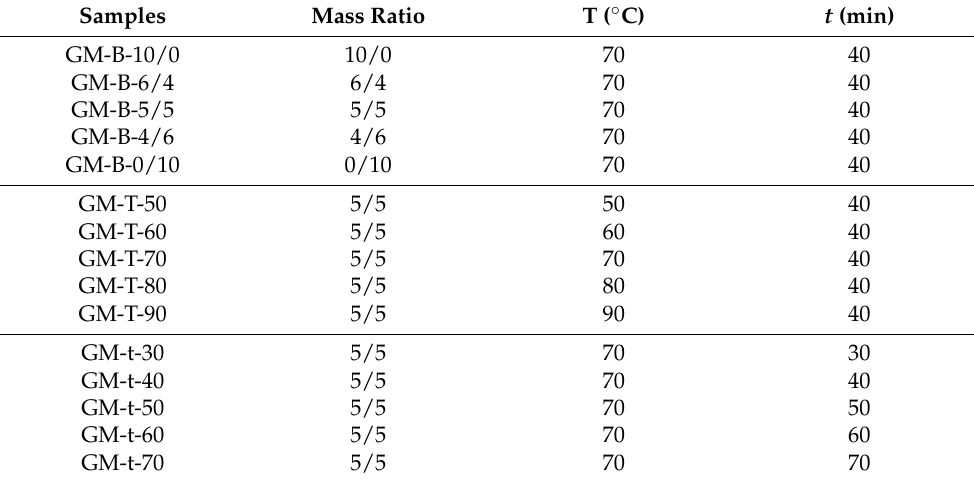
Table 2. The sample labels and reaction conditions of the nano-Mg(OH) 2 powders. Samples Mass